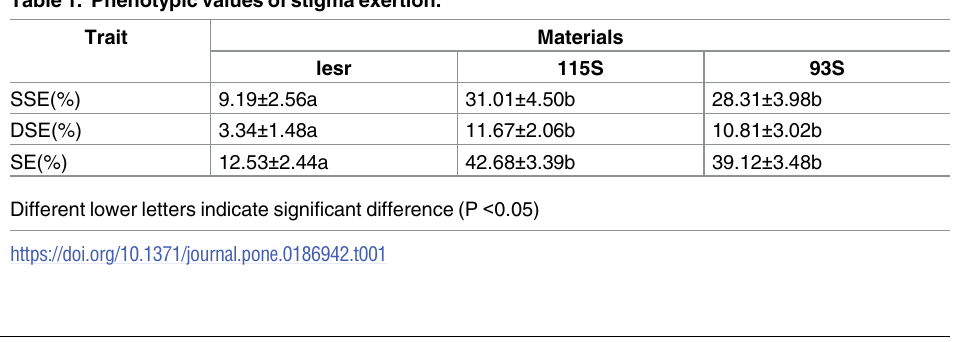
Table 1. Phenotypic values of stigma exertion. Trait